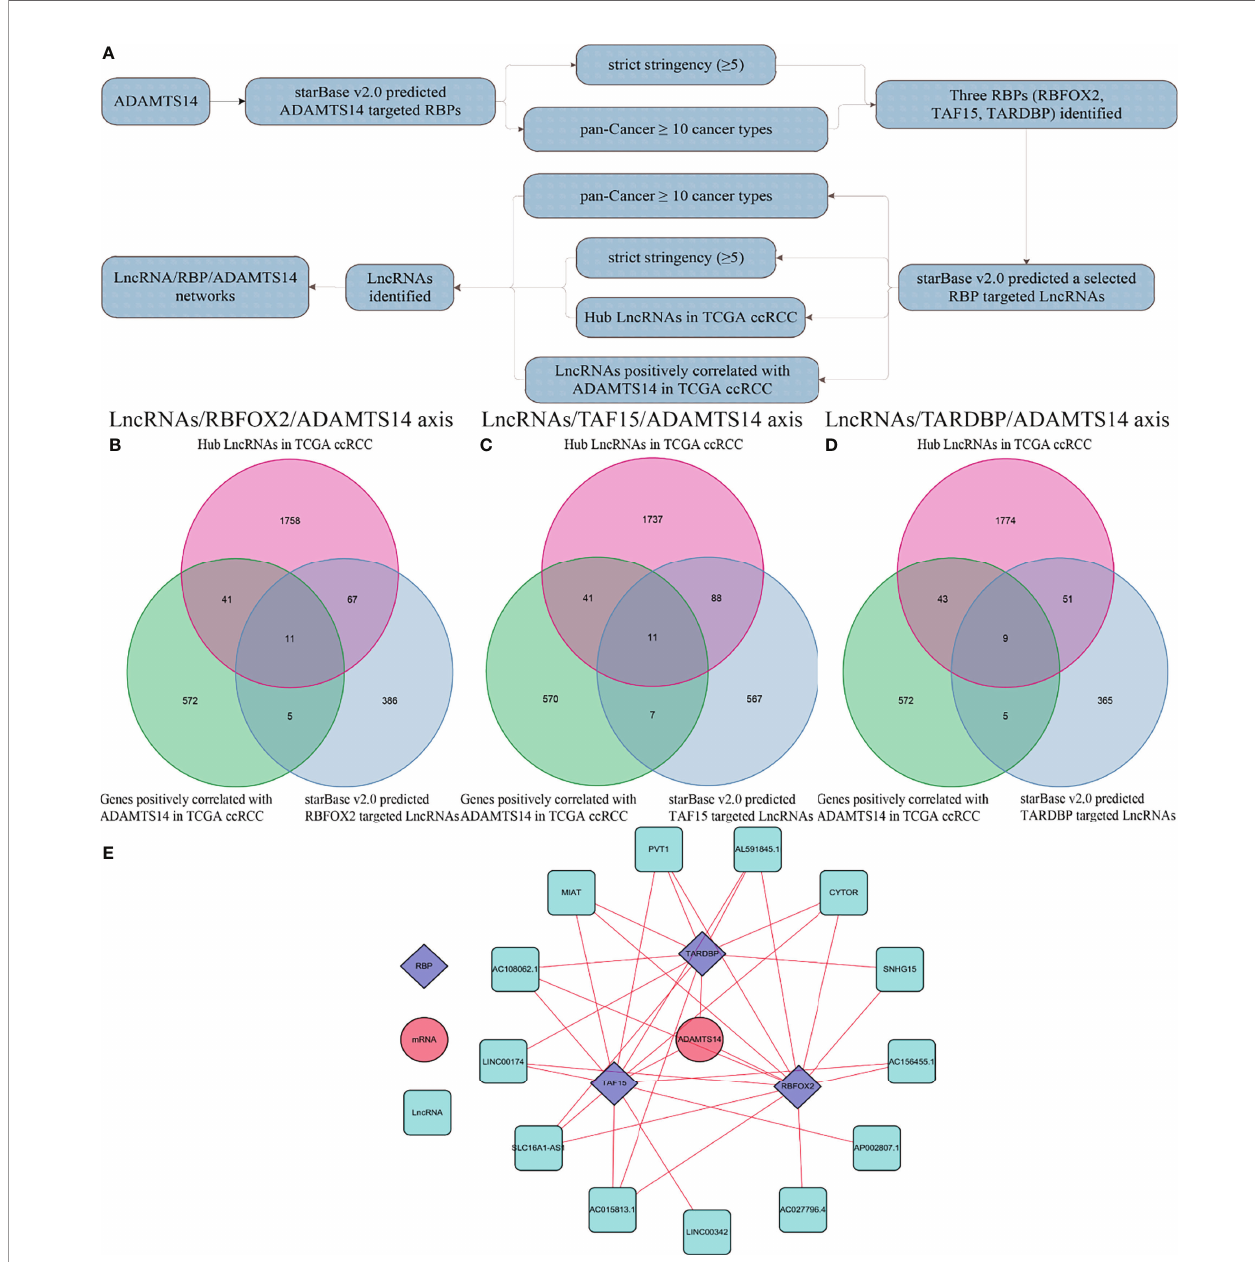
FIGURE 10 | Identi fi cation of LncRNA/RBP/ADAMTS14 mRNA networks in ccRCC patients from TCGA dataset. (A) The whole fl ow chart of identi fi cation. (B) Venn diagrams of LncRNAs/RBFOX2/ADAMTS14 axes. (C) Venn diagrams of LncRNAs/TAF15/ADAMTS14 axes. (D) Venn diagrams of LncRNAs/TARDBP/ADAMTS14 axes. (E) LncRNA/RBP/ADAMTS14 mRNA networks by Cytoscape